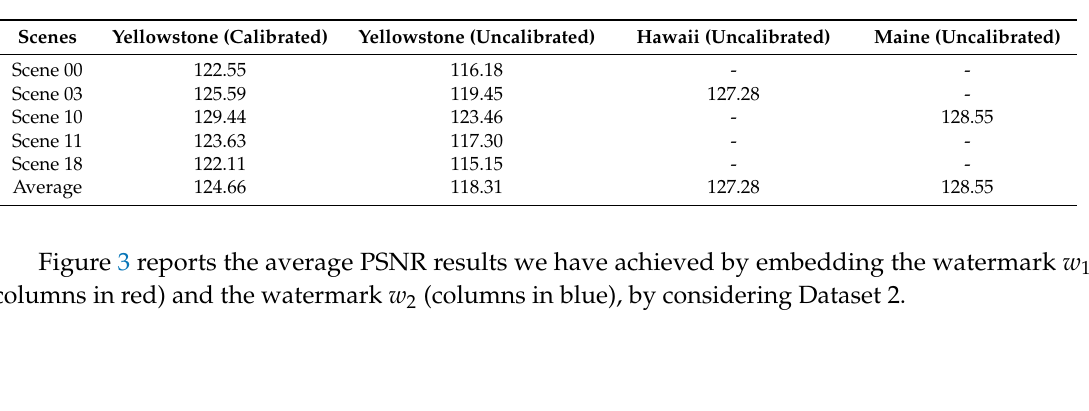
Table 6. Achieved results in terms of PSNR, by embedding w 2 (Dataset